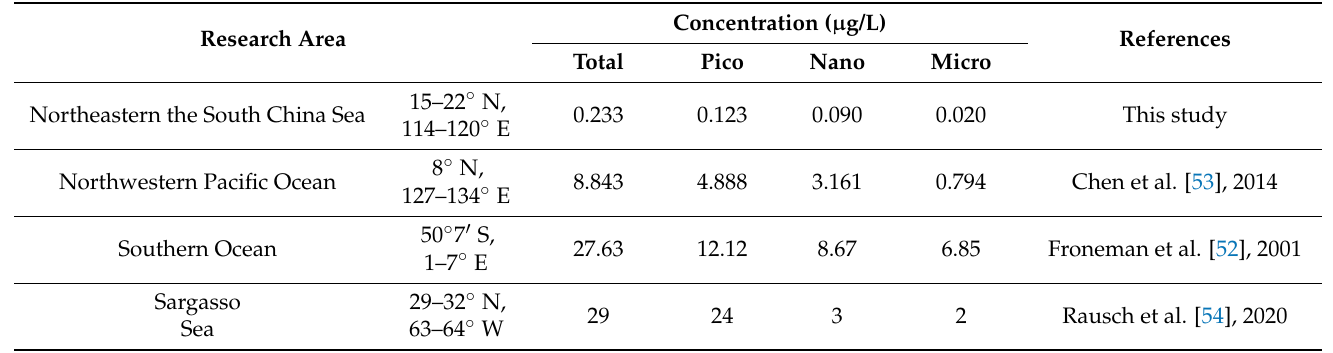
Table 5. Comparison with other areas affected by